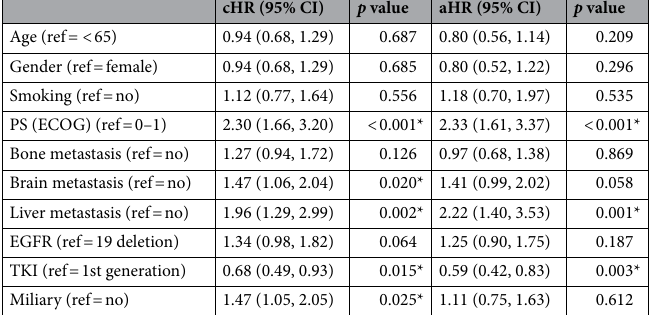
Table 3. Associations between miliary and PFS.